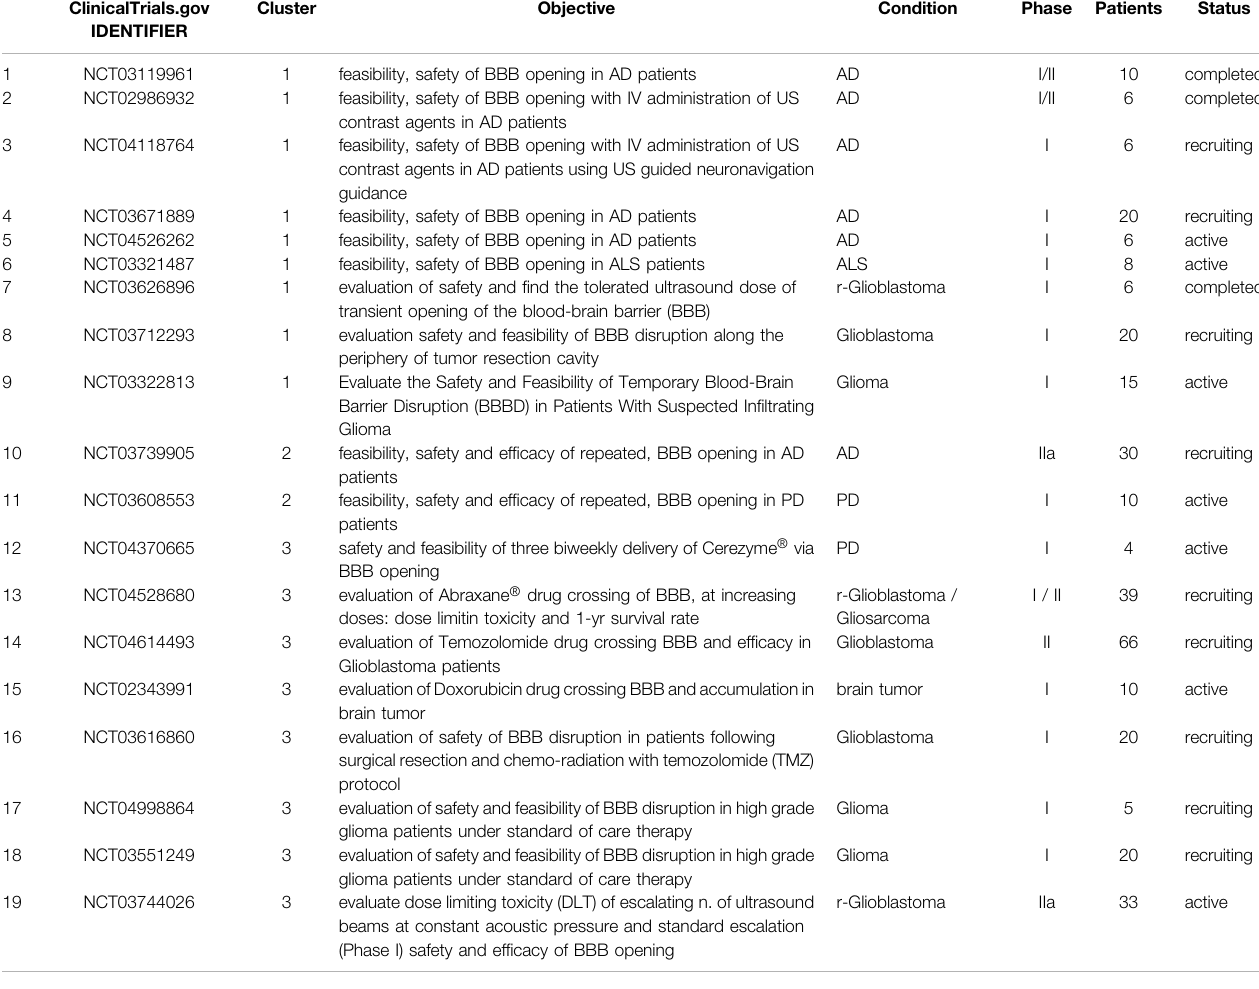
TABLE 1 | Current status (August 2021) of Clinical Trials on BBB opening. AD: Alzheimer ’ s Disease; ALS: Amyotrophic Lateral Sclerosis; PD: Parkinson ’ s Disease. ClinicalTrials.gov IDENTIFIER